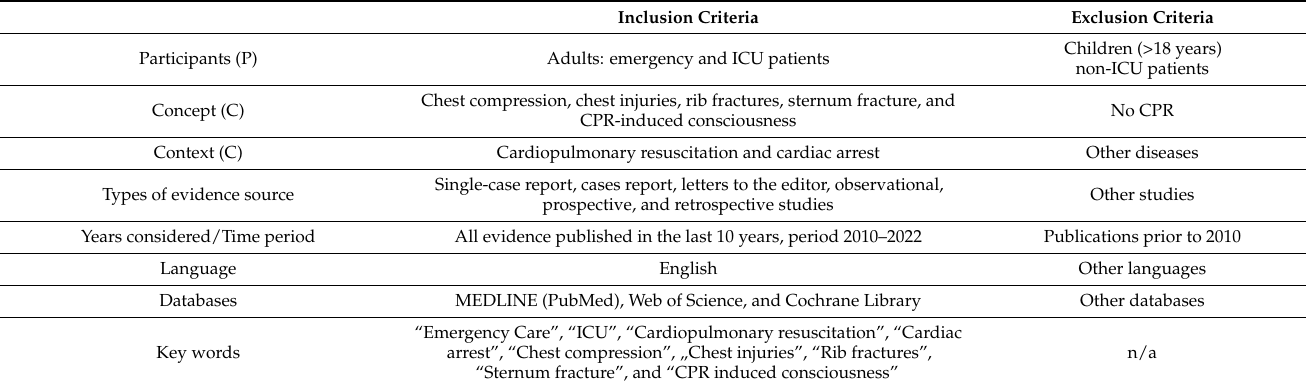
Table 1. PCC framework, inclusion and exclusion criteria, and search